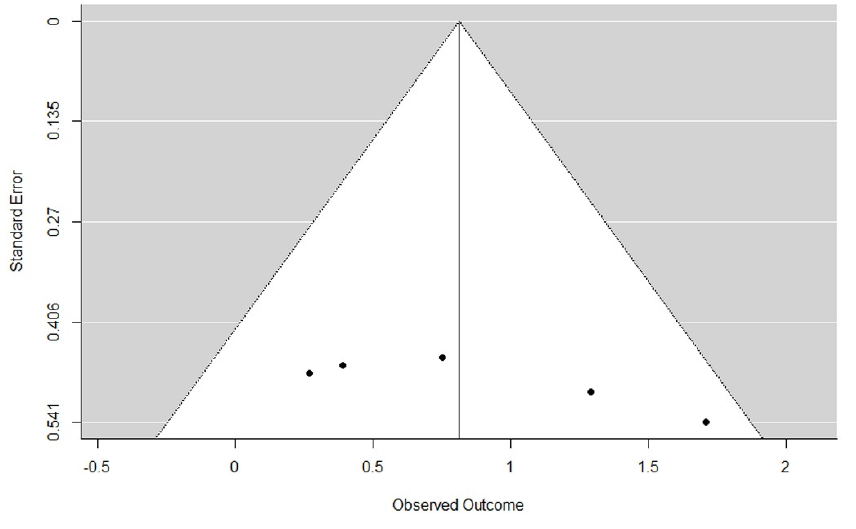
Figure 3. Funnel plot for the TUG measure.